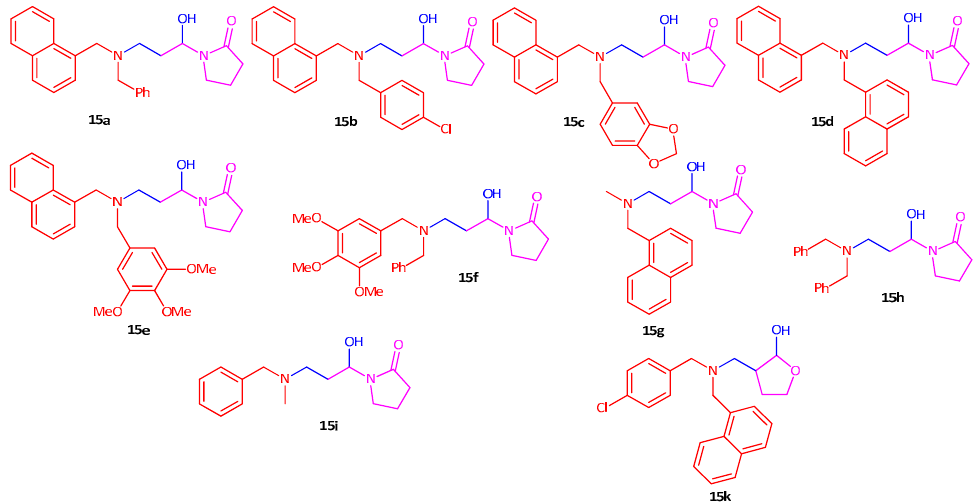
Figure 3. Set of γ -aminoalcohols 15 obtained via a three-component Mannich-type reaction.